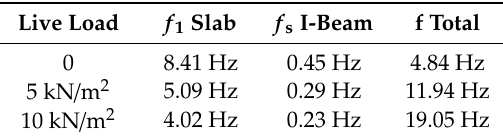
Table 2. Calculated fundamental